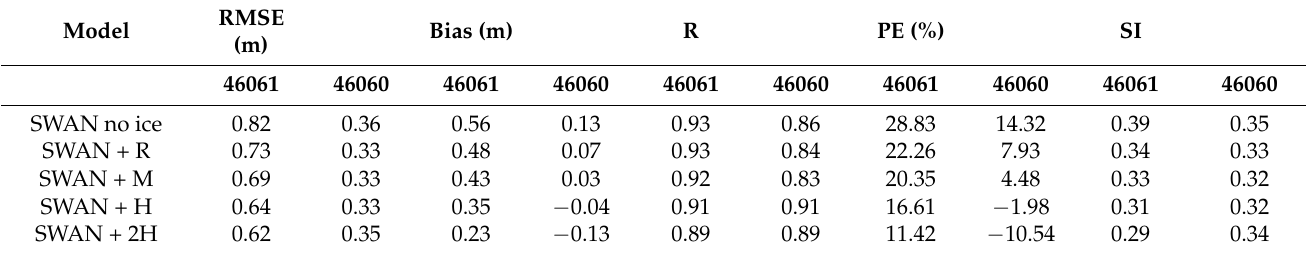
Figure 8. Root mean square error, correlation coefficient, and bias of comparisons between the SWAN model and the buoys for the month of December from 2016–2019. The RMSE is the distance from the origin, the correlation coefficient is shown as the angle from the y-axis, and the bias is the shown as the color of the marker. ( a ) The comparison at buoy 46061 near the mouth of PWS; ( b ) the comparison at buoy 46060 inside PWS. Table 4. SWAN model performance with no ice and four sets of ice coefficients during December of